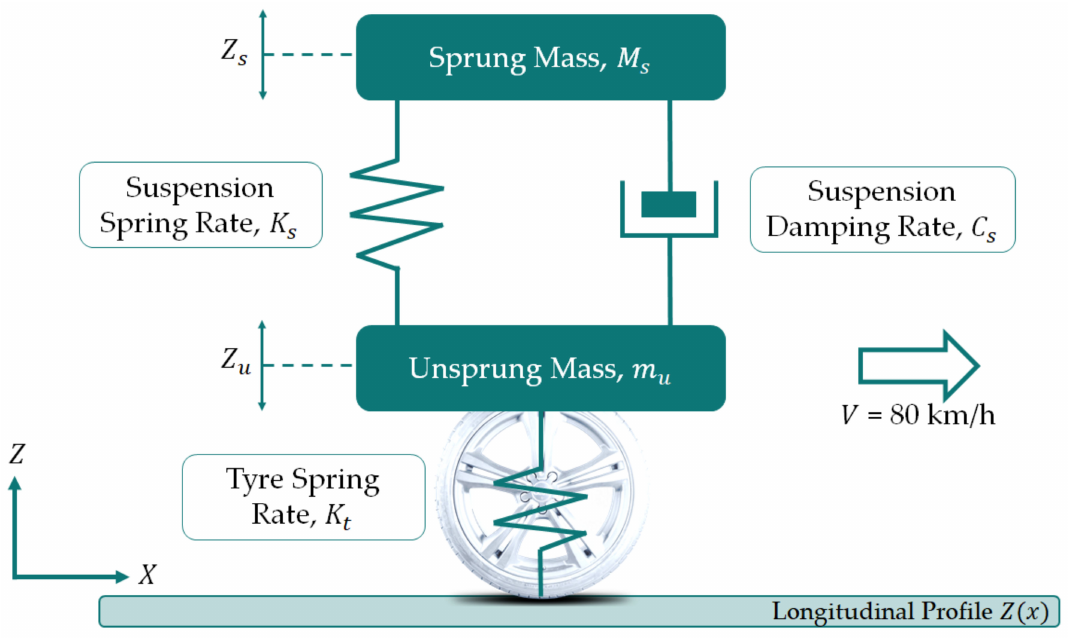
Figure 10. The quarter car